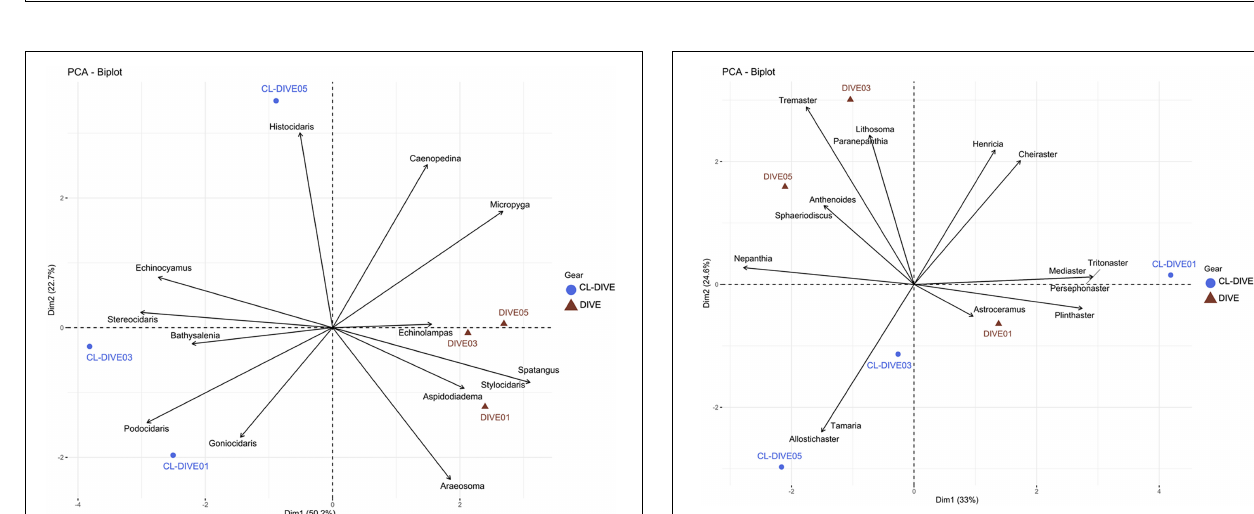
FIGURE 8 | Comparison of crustacean assemblages between imagery (dive) and sampling along dive (cl-dive) along (A) sedimented slope habitats (PNG) (53.4% of variance on first two PCs) and (B) volcanic island slopes (Mayotte) (59.5% of variance on first two PCs). Principal Component Analysis (PCA) of Hellinger-transformed presence/absence crustacean data at genus rank.